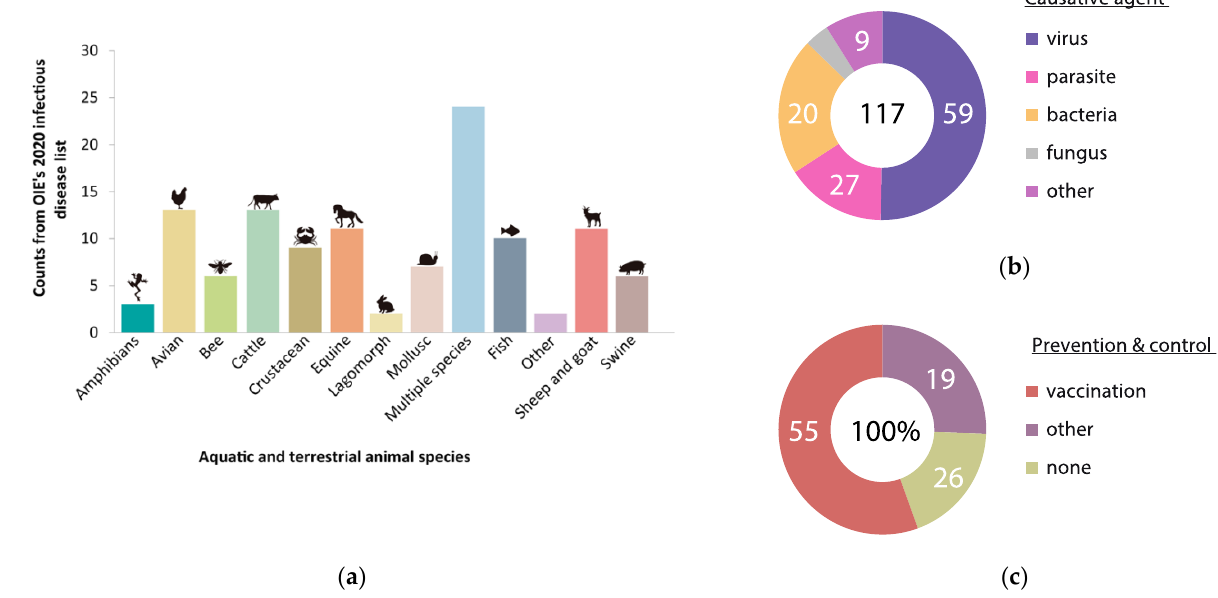
Figure 1. Animal Diseases, Infections and Infestations: ( a ) Counts of terrestrial and aquatic animal diseases published at OIE’s 2020 infectious diseases list; ( b ) Causative agent of the animal diseases reported in absolute values; ( c ) Prevention and control treatments in animal diseases reported in percentage values.